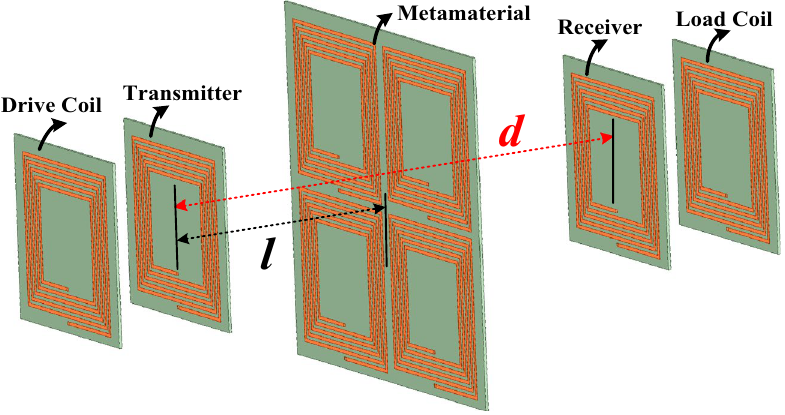
Figure 1. The frequency reconfigurable MRCWPT system with the frequency reconfigurable